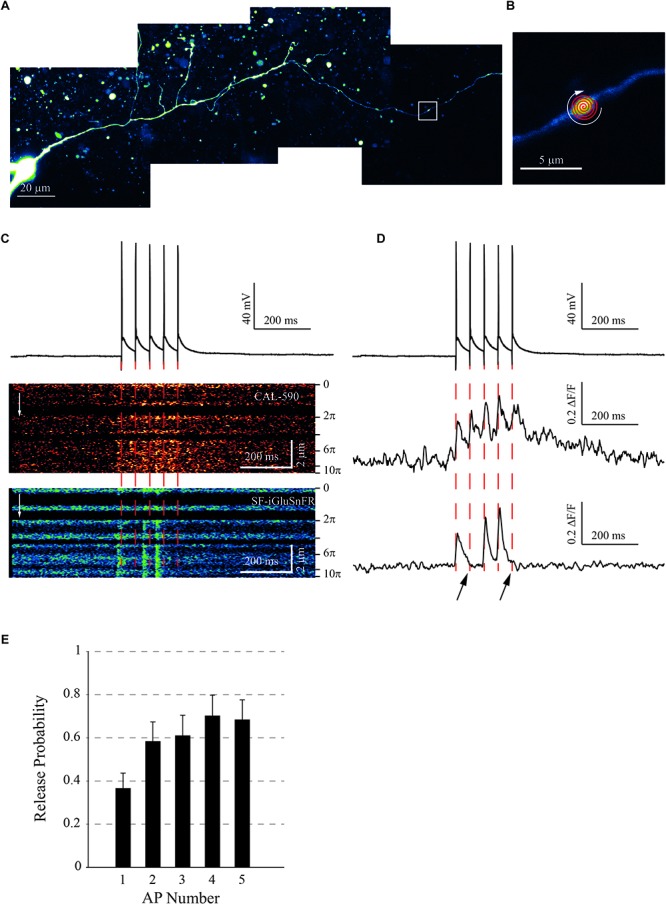
Experimental Protocol. (A) Dentate gyrus granule cell expressing SF-iGluSnFR A184V, maintained in current-clamp. Collage of 20 μm deep image stacks, axon was followed to the bouton of interest (white square). (B) Area shown by the white square in panel (A). A small varicosity (<2μm) reveals a typical en-passant bouton. The fast “Tornado” (spiral) line-scan was set-up to cover most of the bouton visible area. (C) Typical imaging protocol. Traces: Five APs initiated by brief (5 ms) current pulses at 20 Hz (holding voltage −80 mV); Image panels: Tornado line-scans recorded in the Cal-590 (upper) and SF-iGluSnFR (lower) emission channels. (D) Same recordings as in panel (C), but pixel values were averaged over the length of the tornado line-scan and converted as ΔF/F. Note that for the Cal-590 signal, each AP induced a calcium entry in the presynaptic bouton (middle) whereas APs 2 and 5 failed to induce a glutamate release (bottom, black arrows). (E) Average release probability (mean ± SEM) for the AP train (n = 11 boutons). Note the increasing probability with the AP number, reflecting presynaptic facilitation.